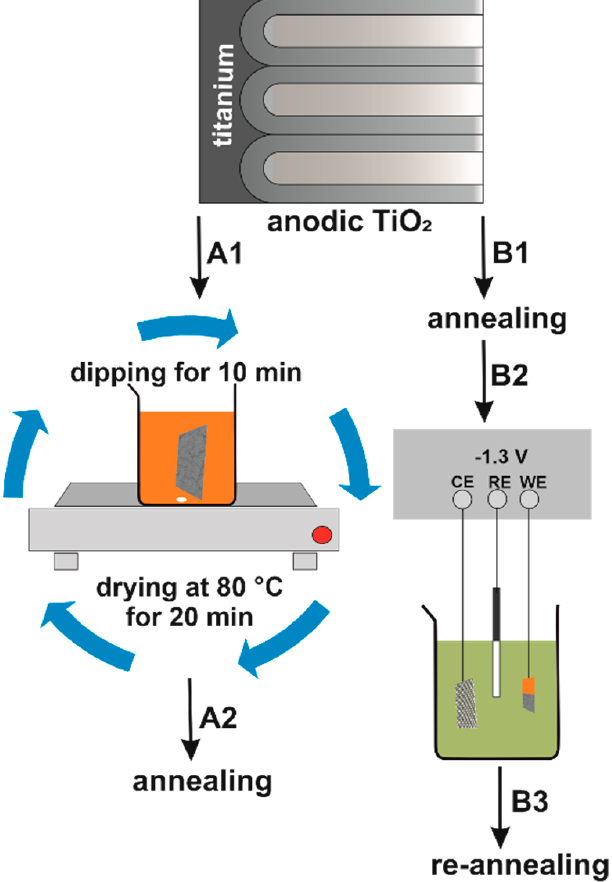
Figure 1. Synthesis of nanostructured Fe 2 O 3 –TiO 2 by impregnation ( A1 ) and electrochemical deposition ( B2 ).